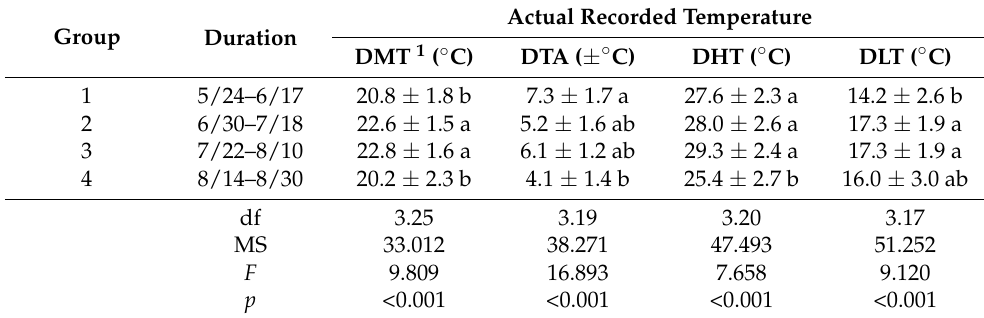
<0.001 <0.001 <0.001 <0.001